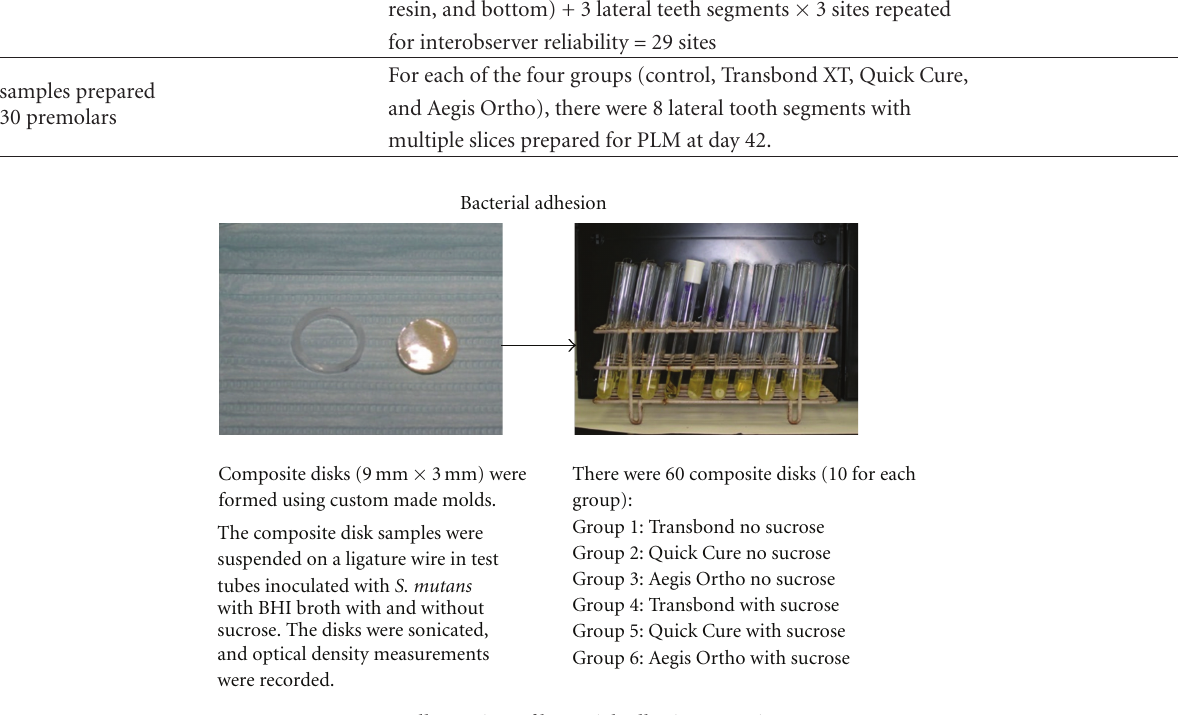
Figure 2: Illustration of bacterial adhesion